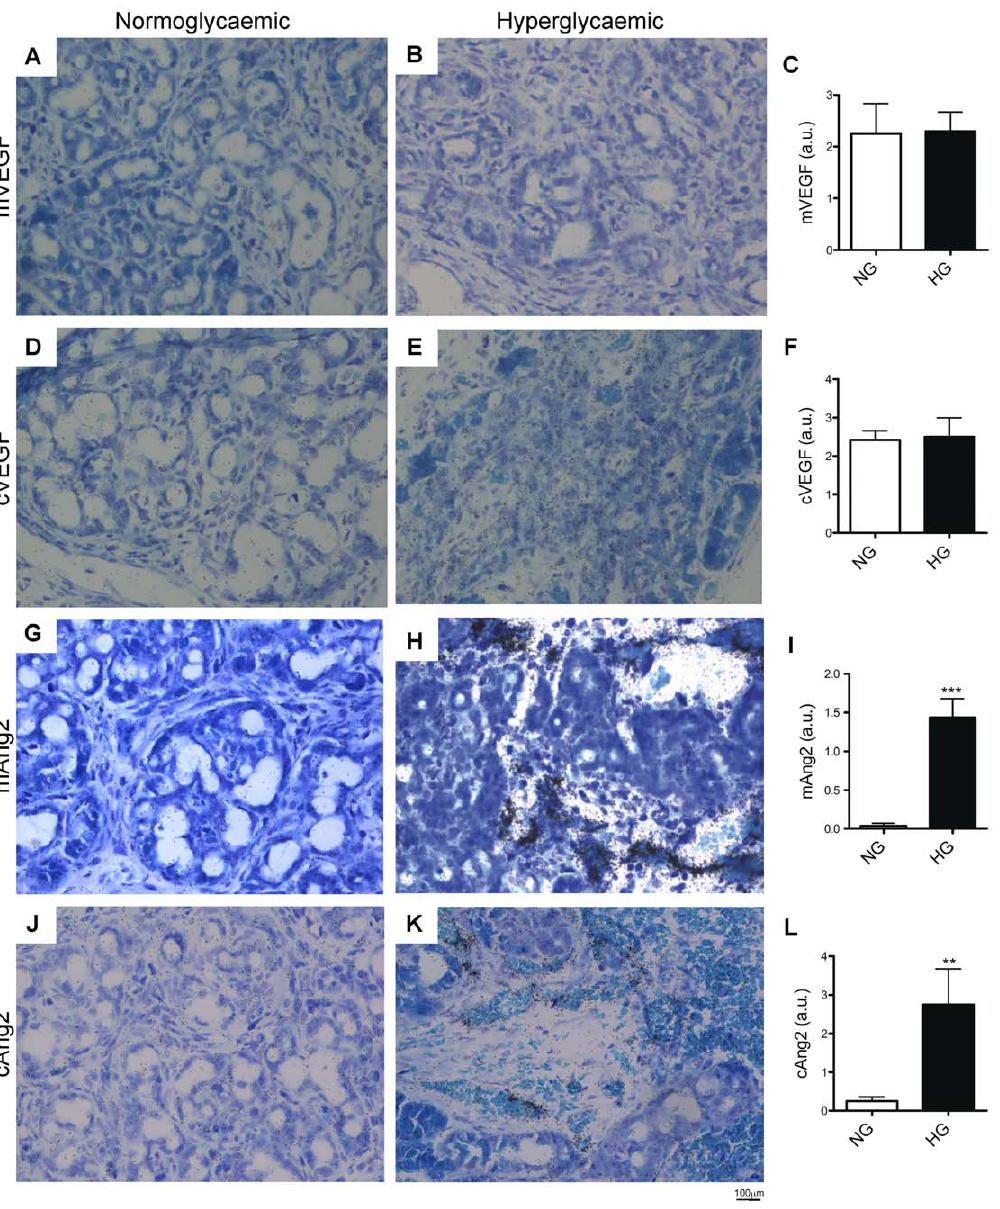
in situ hybridization. C, F, I and L, semi-quantification of labeling intensity between normoglycaemic and hyperglycaemic conditions. Ang2 expressions were increased by hyperglycaemia. Student t -test, **p , 0.01, ***p , 0.001,